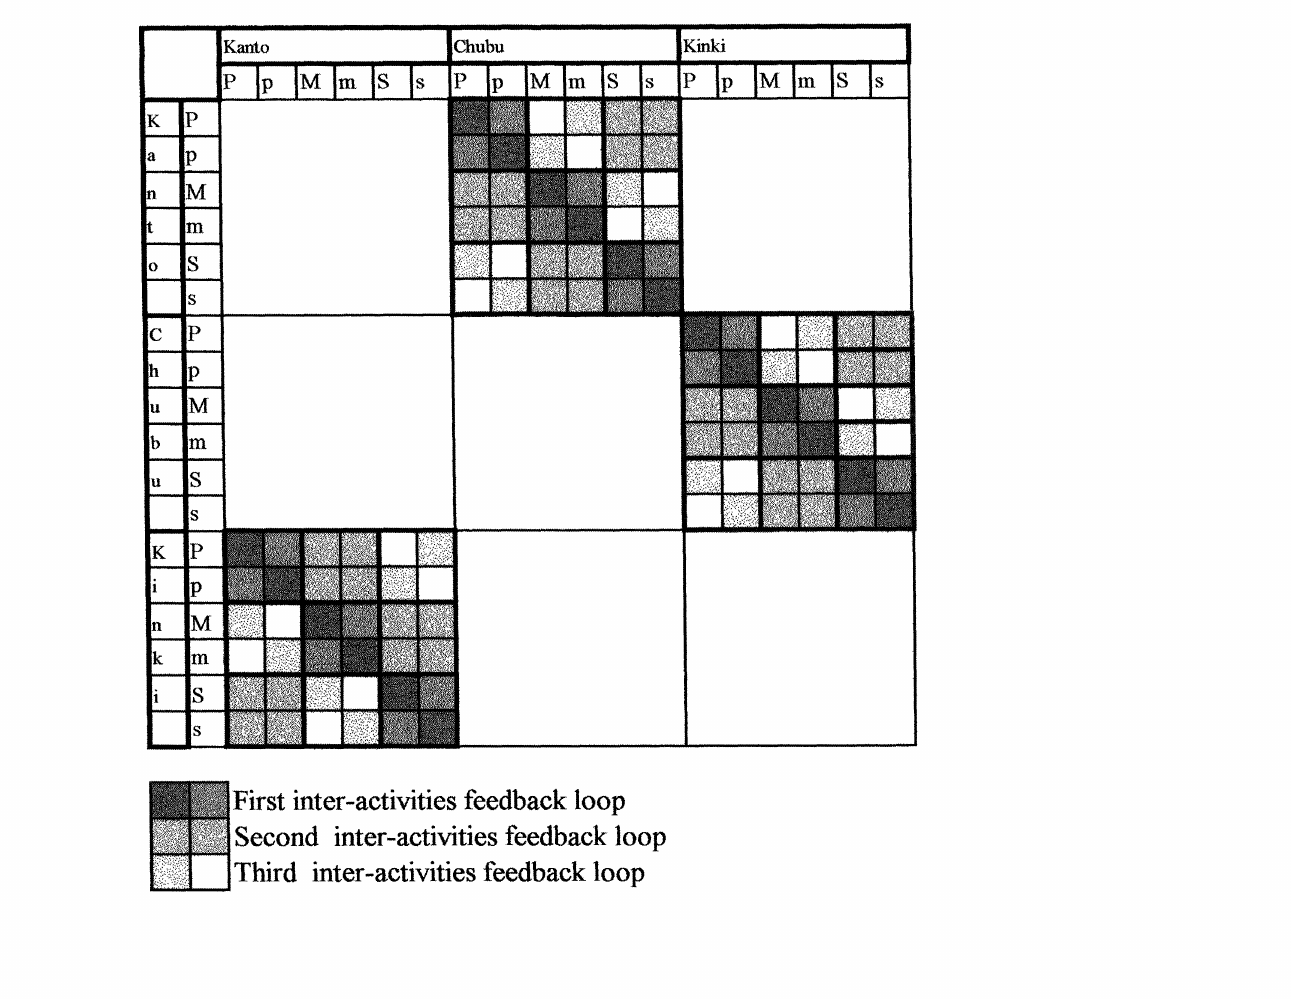
TABLE III Qualitative characterization of the vertical specialization feedback loops for the triad (Kanto, Chubu, Kinki) from the first inter-regional, inter-activities feedback loop,